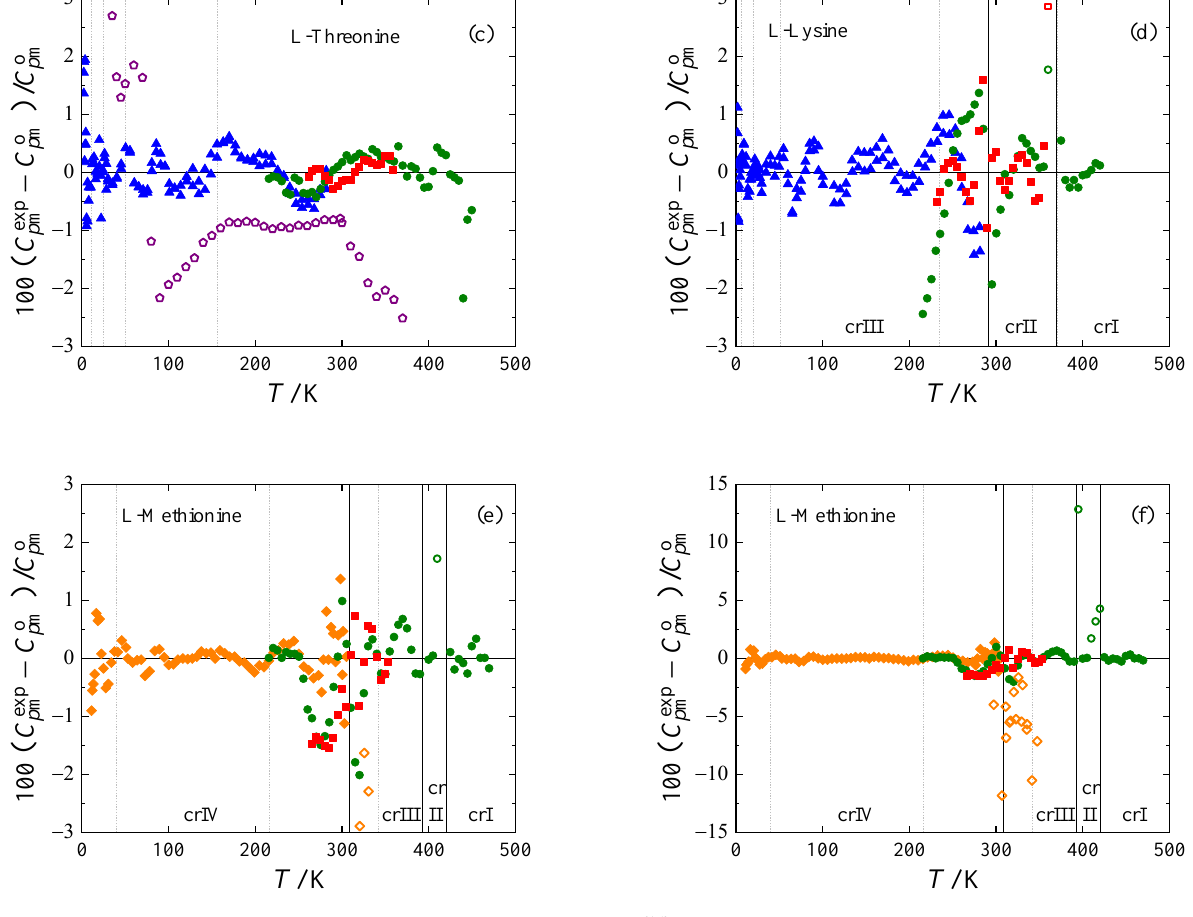
Figure 3. Relative deviations of individual experimental heat capacities Figure 3. Relative deviations Figure 3. Relative deviations 100 ( C exp p m − C o p m ) / C o p m of individual experimental heat capacities exp Figure 3. Relative deviations exp o o m m m 100( C - of individual experimental heat capacities C from values o C calculated by means of Equations (1) and (2) with parameters from Table C exp p m from values C o p m calculated by means of Equations (1) and (2) with parameters from Table 5. calculated by means of Equations (1) and (2) with parameters from Table m p m p exp ( a ) L-cysteine, ( b ) L-serine, ( c ) L-threonine, ( d ) L-lysine, and ( e , f ) L-methionine. Blue (cid:78) , this work C from values o C calculated by means of Equations (1) and (2) with parameters from Table 5. ( a ) L-cysteine, ( b ) L-serine, ( c ) L-threonine, ( d ) L-lysine, and ( e , f ) L-methionine. Blue  , this work 5. ( a ) L-cysteine, ( b ) L-serine, ( c ) L-threonine, ( d ) L-lysine, and ( e , f ) L-methionine. Blue  , this work m p m p (relaxation calorimetry); red (cid:4) , this work (Tian-Calvet calorimetry); green , this work (power (relaxation calorimetry); red  , this work (Tian-Calvet calorimetry); green  , this work (power (relaxation calorimetry); red  , this work (Tian-Calvet calorimetry); green  , this work (power 5. ( a ) L-cysteine, ( b ) L-serine, ( c ) L-threonine, ( d ) L-lysine, and ( e , f ) L-methionine. Blue  , this work compensation DSC); olive  , Paukov et al. [30] ; brown  , Huffman and Ellis [46] ; orange  , Hutch- compensation DSC); olive  , Paukov et al. [30] ; brown  , Huffman and Ellis [46] ; orange  , Hutch- compensation DSC); olive (cid:70) , Paukov et al. [30]; brown (cid:53) , Huffman and Ellis [46]; orange (relaxation calorimetry); red  , this work (Tian-Calvet calorimetry); green  , this work (power ens et al. [34,47] ; purple  , Lukyanova et al. [12] . Dotted vertical lines mark knot temperatures T i , ens et al. [34,47] ; purple  , Lukyanova et al. [12] . Dotted vertical lines mark knot temperatures T i , compensation DSC); olive  , Paukov et al. [30] ; brown  , Huffman and Ellis [46] ; orange  , Hutch- thick vertical lines phase transition temperatures. Data points represented by filled symbols were thick vertical lines phase transition temperatures. Data points represented by filled symbols were ens et al. [34,47] ; purple  , Lukyanova et al. [12] . Dotted vertical lines mark knot temperatures T i , used to obtain parameters of Equations (1) and (2) in Table 5. used to obtain parameters of Equations (1) and (2) in Table 5. thick vertical lines phase transition temperatures. Data points represented by filled symbols were used to obtain parameters of Equations (1) and (2) in Table 5. Table 6. Standard Thermodynamic Functions of Stable Forms of L-Cysteine, L-Serine, L-Threonine, Table 6. Standard Thermodynamic Functions of Stable Forms of L-Cysteine, L-Serine, L-Threonine, Table 6. Standard Thermodynamic Functions of Stable Forms of L-Cysteine, L-Serine, L-Threonine, L-Lysine, and L-Methionine at p = 0.1 MPa and T = 298.15 K a . L-Lysine, and L-Methionine at p = 0.1 MPa and T = 298.15 K a . L-Lysine, and L-Methionine at p = 0.1 MPa and T = 298.15 K a Table 6. Standard Thermodynamic Functions of Stable Forms of L-Cysteine, L-Serine, L-Threonine, L-Lysine, and L-Methionine at p = 0.1 MPa and T = 298.15 K a . Compound Compound